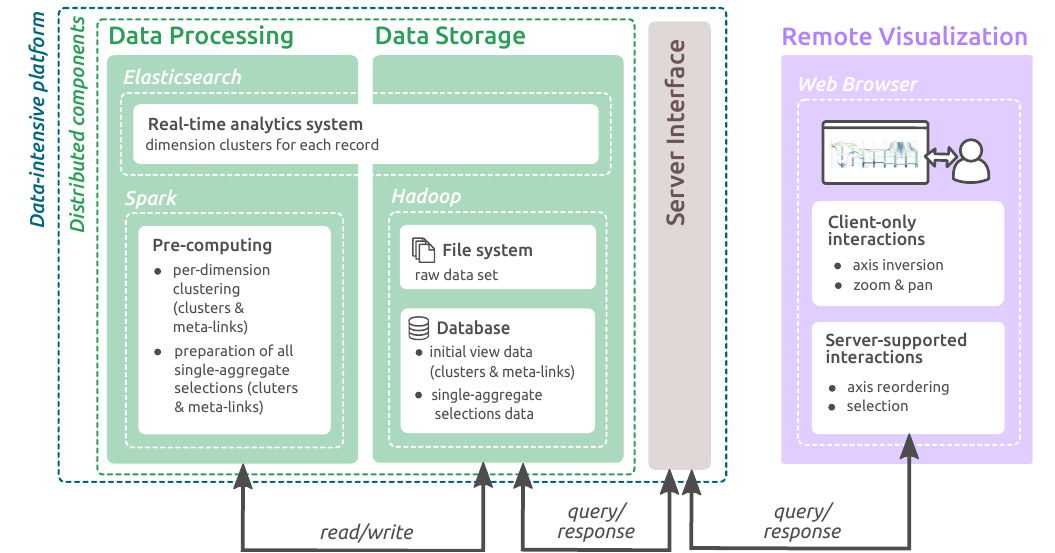
Figure 2. System components. Data processing steps using Spark occur once and consist in the clustering of dimension values, forming the abstraction (clusters and meta-links) for the initial view and all axis ordering, as well as preparing all single-aggregate selections. The server interface communicates with two types of storage system to answer queries received from the rendering client, one holding prepared data, the other processing aggregation